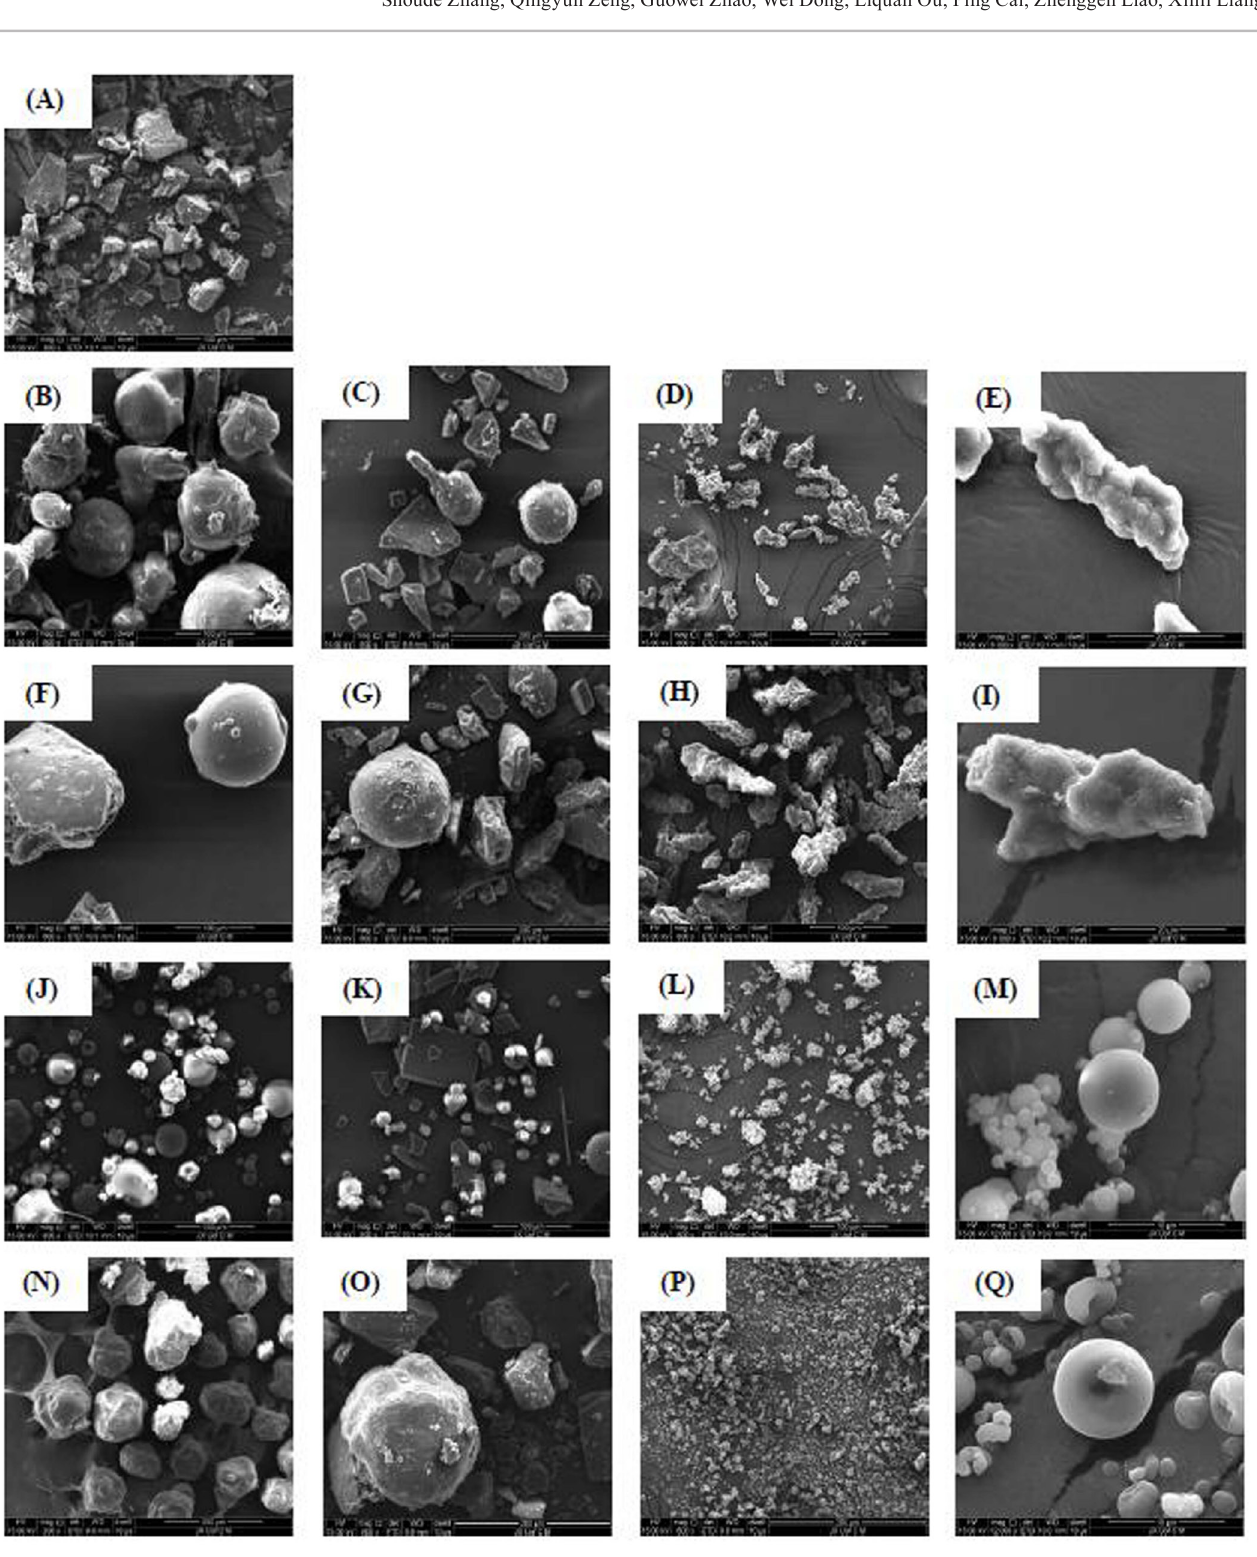
FIGURE 5 - SEM photographs of samples: (A) AG, (B) PEG8000, (C) AG-PEG8000-PM, (D) AG-PEG8000-SD, (E) AG-PEG8000- SD, (F) Poloxamer188, (G) AG-Poloxamer188-PM, (H) AG-Poloxamer188-SD, (I) AG-Poloxamer188-SD, (J) PVPK30, (K) AG- PVPK30-PM, (L) AG-PVPK30-SD, (M) AG-PVPK30-SD, (N) Soluplus®, (O) AG-Soluplus ® -PM, (P) AG-Soluplus ® -SD, (Q) AG-Soluplus ®